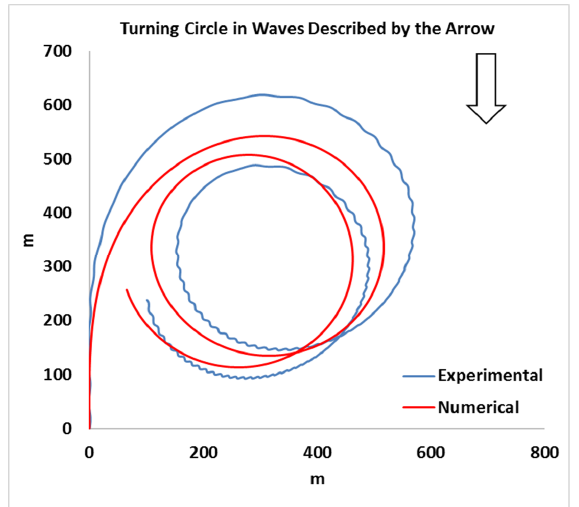
Figure 11. KCS’s experimental and numerical starboard-side 35 deg turning trajectories regular wave